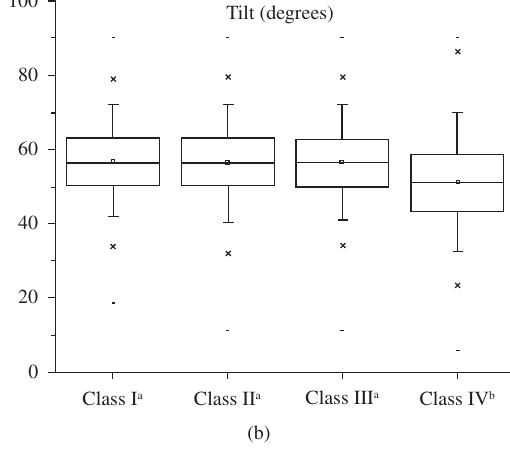
Figure 9. Tilt angle: a) per tooth; and b) per class of